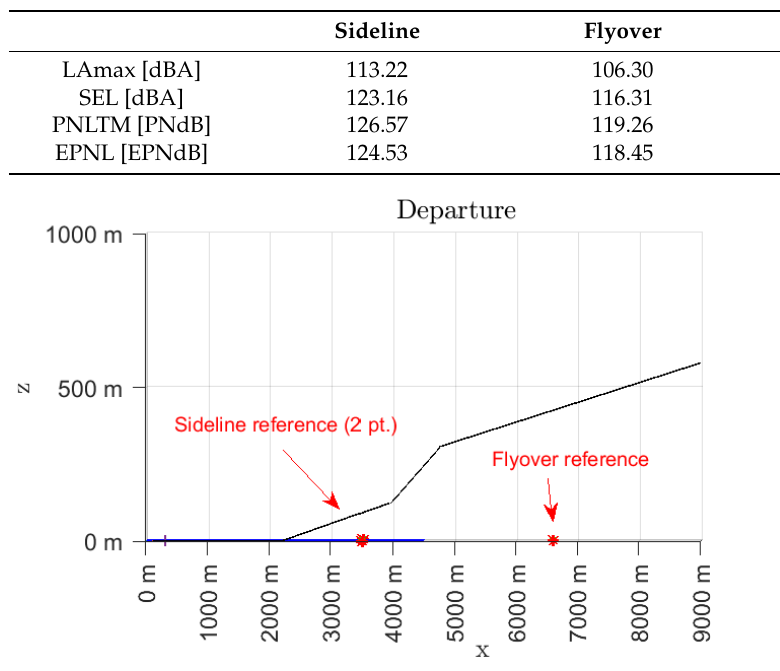
Figure 8. Simulated departure flight